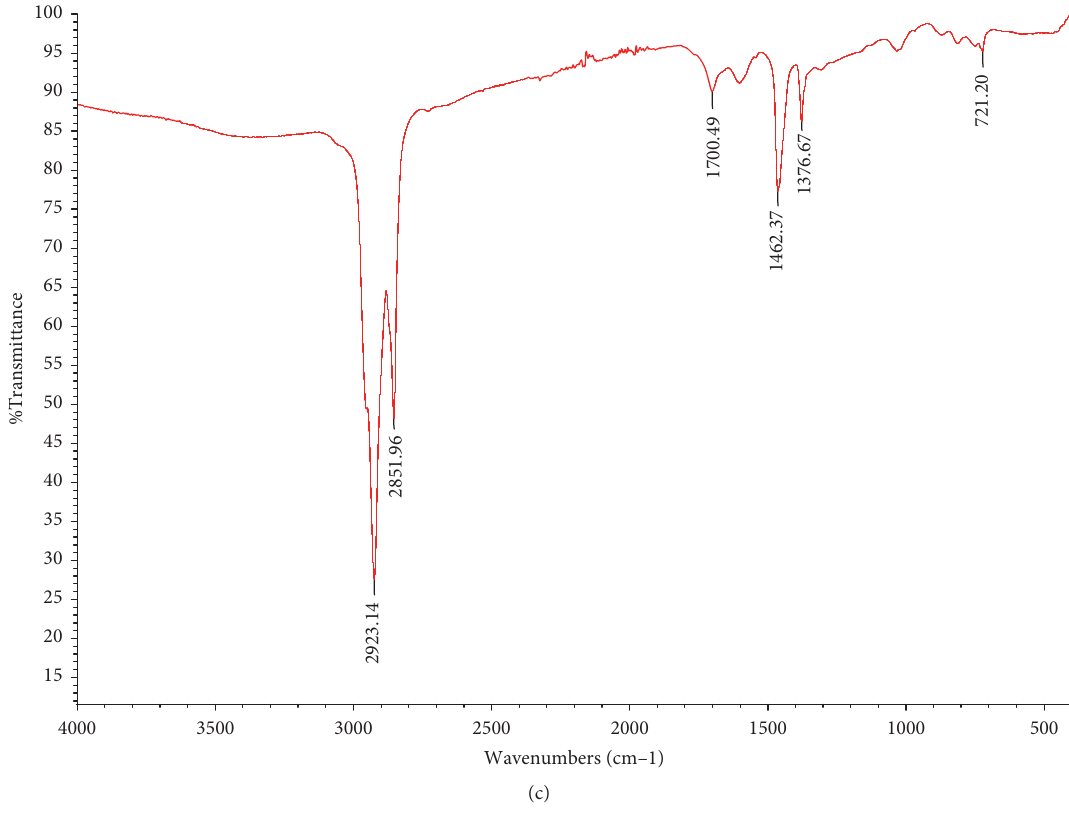
Figure 3: (a) Transmittance peaks of unmodified bitumen. (b) Transmittance (%) vs. wavenumber (cm − 1 ) spectral interpretation of